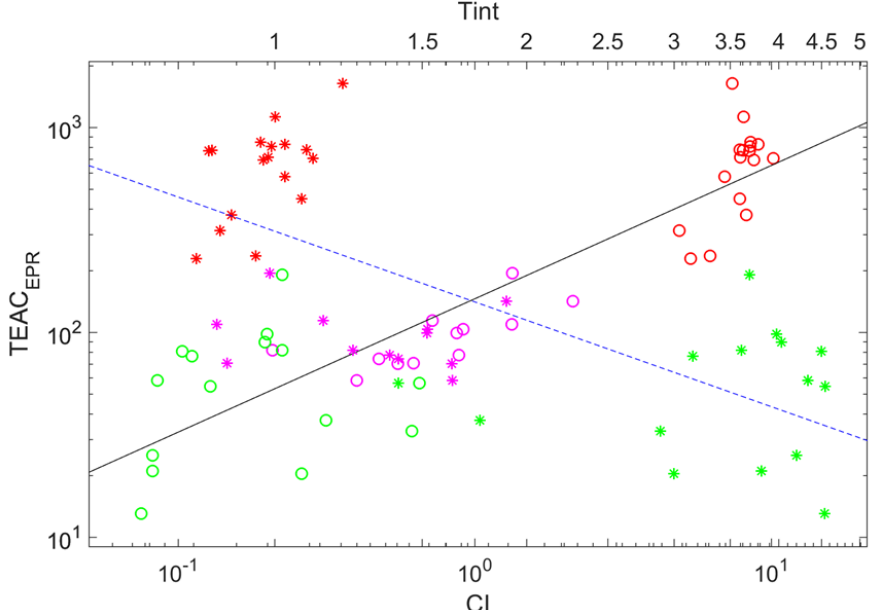
Figure 4. Double logarithmic plot showing the power-law dependencies of the trolox equivalent antioxidant capacity determined by EPR on the color intensity (circles, lower abscissa axis) and tint (asterisks, upper abscissa axis). The solid and the dashed lines denote fits stated by Equations (4) and (3), respectively. Circle color indicates wine color: red (red wines), magenta (rose wines), and green (white